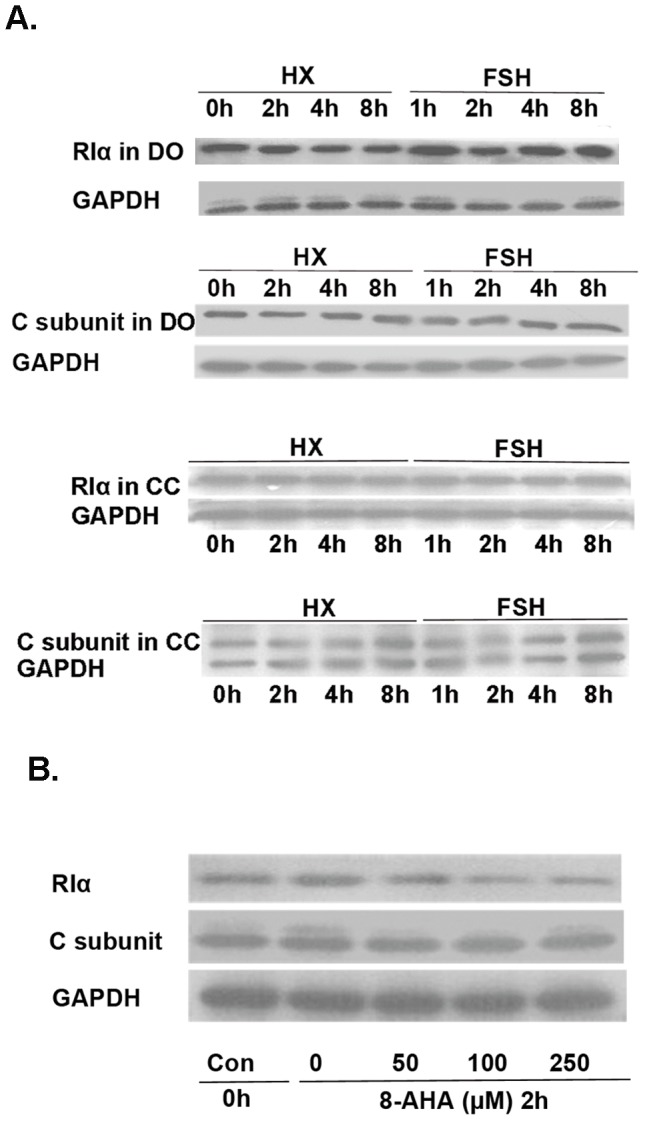
Effects of FSH on PKAI, and decrease in PKAI regulatory subunit (RIα) levels after activation of PKAI.(A) FSH reduced PKAI regulatory subunit RIα levels, but not levels of the catalytic subunit (C) of PKAI, in oocytes of COCs (DOs), but not cumulus cells (CCs), 2 h after the start of culture. DOs and CCs from 200 COCs treated/not treated with FSH were collected at various time points and analyzed by Western blotting. (B) PKAI activation resulted in a decrease in RIα levels in oocytes. COCs were incubated in HX medium supplemented with increasing concentrations of 8-AHA-cAMP (0–250 µM) for 2 h. Oocytes of COCs were collected at 2 h for Western blotting analysis of PKAI RIα and C levels. 8-AHA-cAMP reduced oocyte RI levels in a dose-dependent fashion, but had no obvious effect on PKAI C levels. Western blotting experiments were performed at least three times with similar results. The blot shown is representative of three experiments.